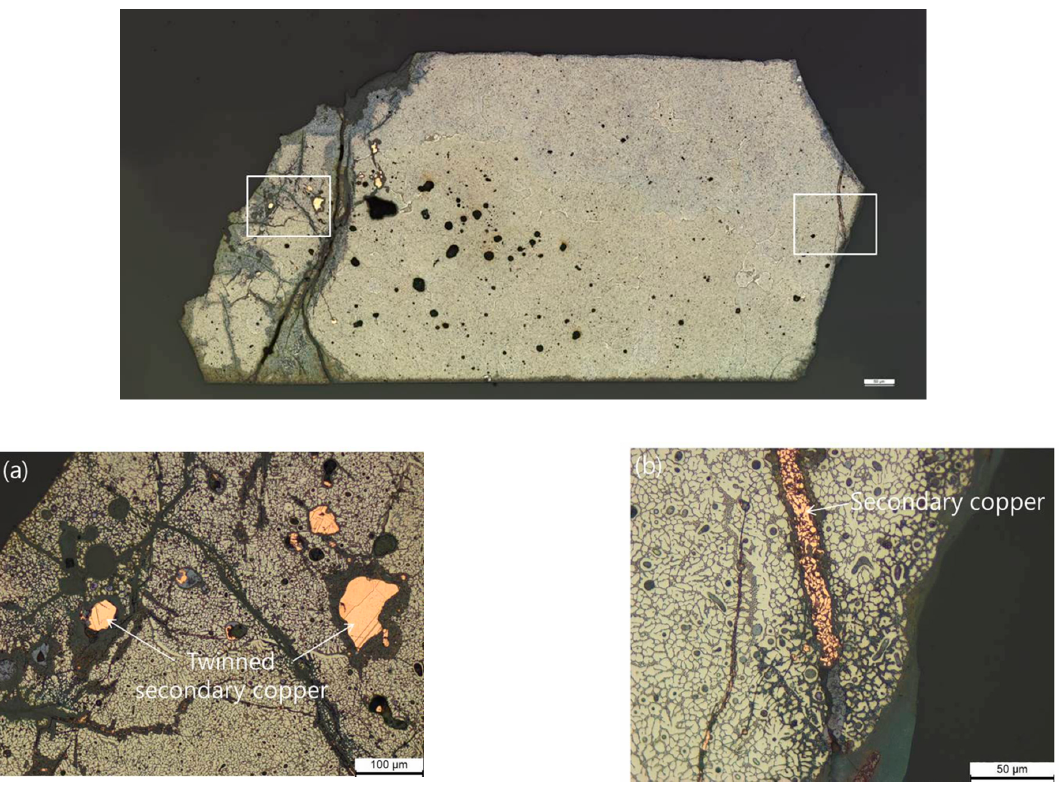
Figure 8. Ga-31 (No. 2) optical micrograph images showing ( a ) twinned secondary copper and ( b ) secondary copper in corrosion.